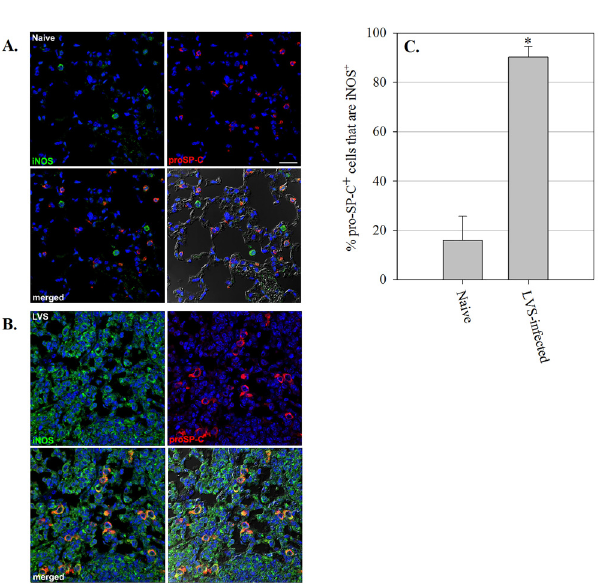
Fig 3. ATII cells in the lungs of mice produce iNOS during in vivo pulmonary F . tularensis LVS infection. (A) Na ï ve control mice, and (B) mice intranasally inoculated with 2x10 2 CFU of F . tularensis LVS (lungs collected on day 7 after infection). Lungs were harvested and prepared for immunofluorescence analysis. (C) Percentage of pro-SP-C + cells that stained positively for iNOS in na ï ve and LVS-infected mouse lungs. Five separate images were quantitated per mouse. Data are expressed as mean ± SD of individual mice. Nuclei were stained with Hoechst 33258 (blue) to visualize lung cells. Sections were probed with fluorescently labeled antibody to pro-SP-C (red) and iNOS (green) to identify lung epithelial cells expressing iNOS. The lower right corner of each panel is a DIC/merged image. Scale bar, 250 μ m. Representative images are shown. * = P < 0.001 as compared to na ï ve